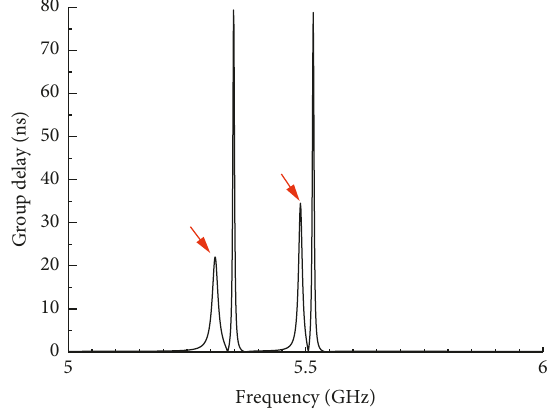
Figure 15: Simulated transmission group delay corresponding to the third proposed resonator (structure